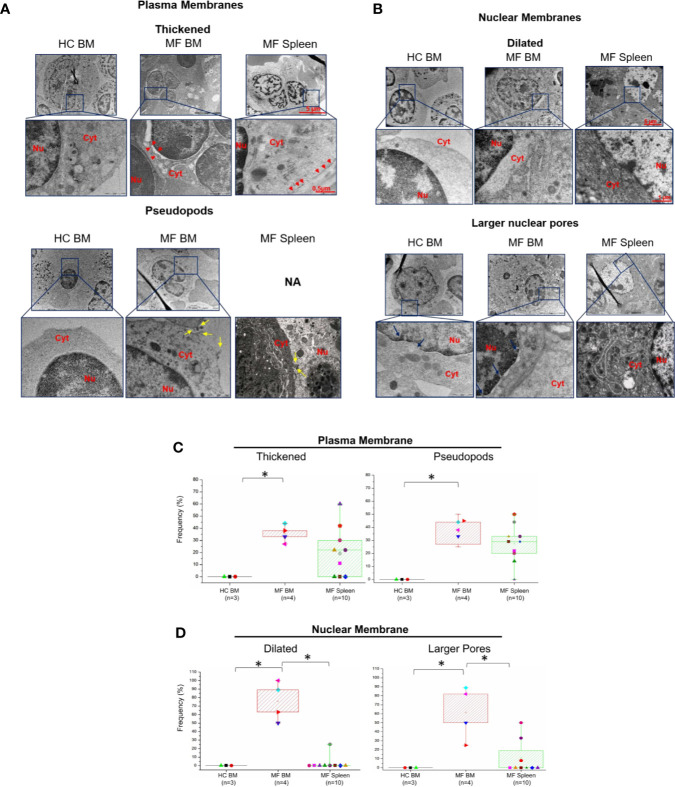
The membranes of megakaryocytes from BM of MF patients show unique ultrastructural abnormalities suggesting impaired membrane biosynthesis. Details of the plasma (A) and nuclear (B) membranes of representative megakaryocytes from BM and spleen of one control (HC) and one MF patient. The plasma membrane of megakaryocytes from MF BM appears thick and with numerous pseudopods while the nuclear membrane is dilated and with large nuclear pores. Red arrowheads indicate thick plasma membranes, yellow and blue arrows indicate pseudopods and large nuclear pores, respectively. Nu, nucleus, Cyt, cytoplasm. N.A., not available. Magnification 5,800× for megakaryocytes, 37,000× and 23,000× for the details of the plasma and nuclear membranes, respectively. Scale bars = 5 μm (5,800×), 1 μm (23,000×), and 0.5 μm (37,000×). (C, D) Frequency of megakaryocytes presenting ultrastructural abnormalities of plasma and nuclear membranes with respect to the total number of viable megakaryocytes analyzed per experimental group. Results are presented as median (lines across boxes), 25–75% inter-quartile range (boxes), and maximum and minimum values (the end of the vertical line across the boxes); see legend of Figure 1 for further detail. The number of subjects included in each experimental group is indicated by n and the average number of megakaryocytes analyzed per group was 6 for HC BM, 35 for MF BM, and 91 for MF spleen. *p < 0.05 with respect to the indicated value.